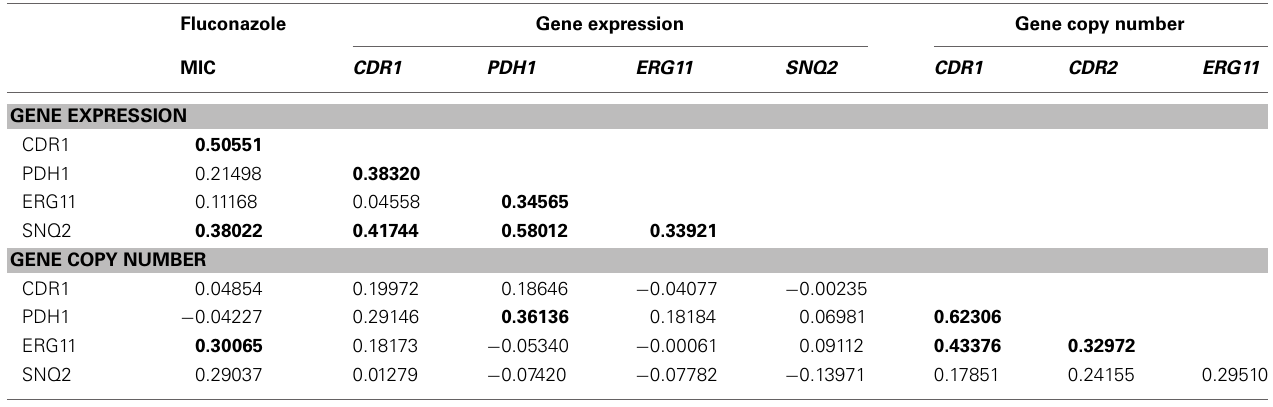
Table 5 | Spearman rank correlation coefficients between the fluconazole MICs and the normalized expression level and copy number of CDR1 , PDH1 , ERG11 , and SNQ2 genes.